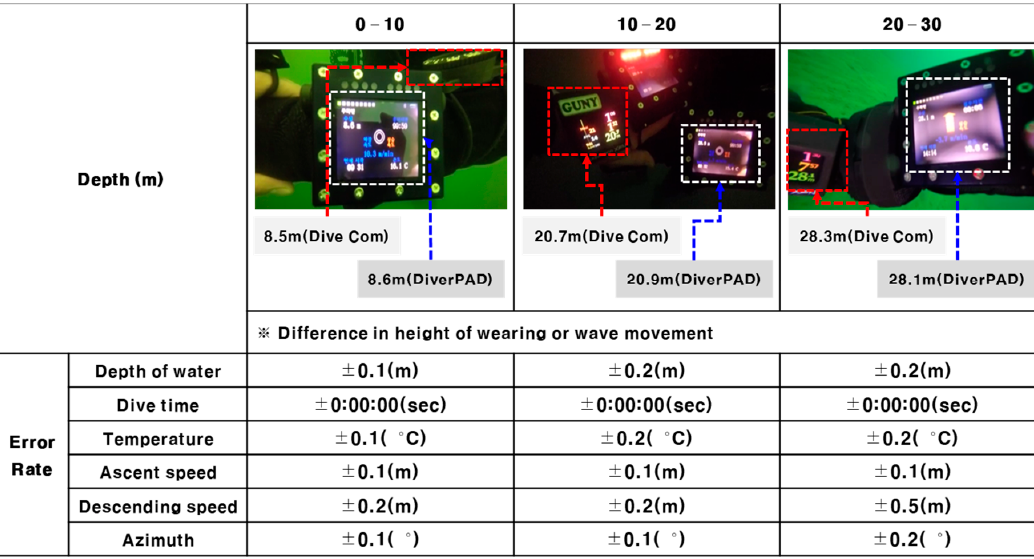
Figure 10. Test environment of DiverPAD.